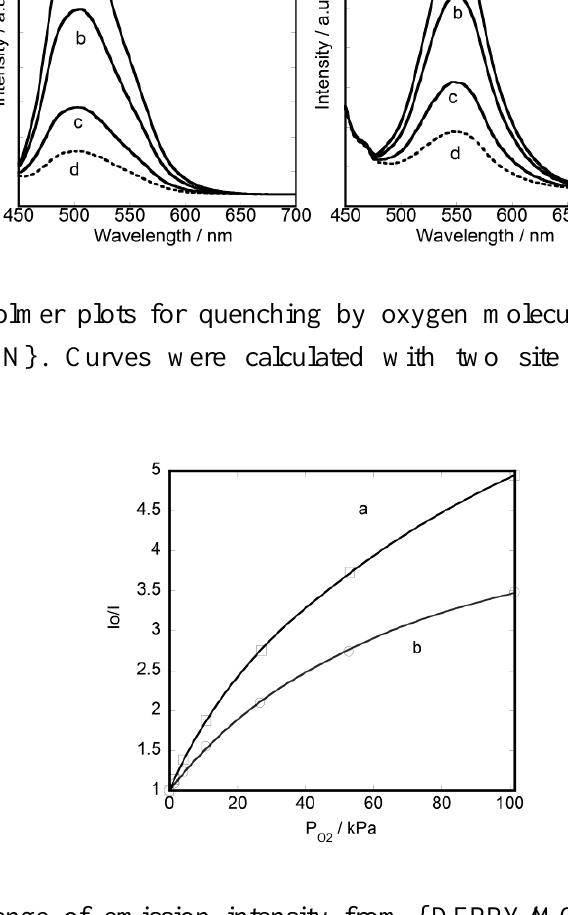
Figure 4. The change of emission intensity from {DFPPY/MON}, when oxygen gas was introduced and evacuated. The excitation and emission wavelengths were 430 nm and 500 nm at room temperature, respectively (modified from reference